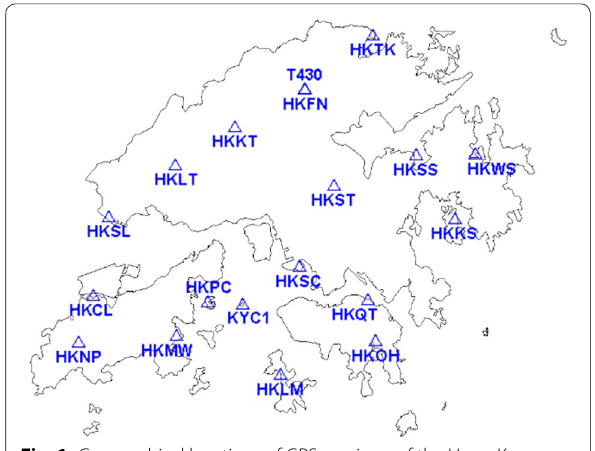
Fig. 1 Geographical locations of GPS receivers of the Hong Kong